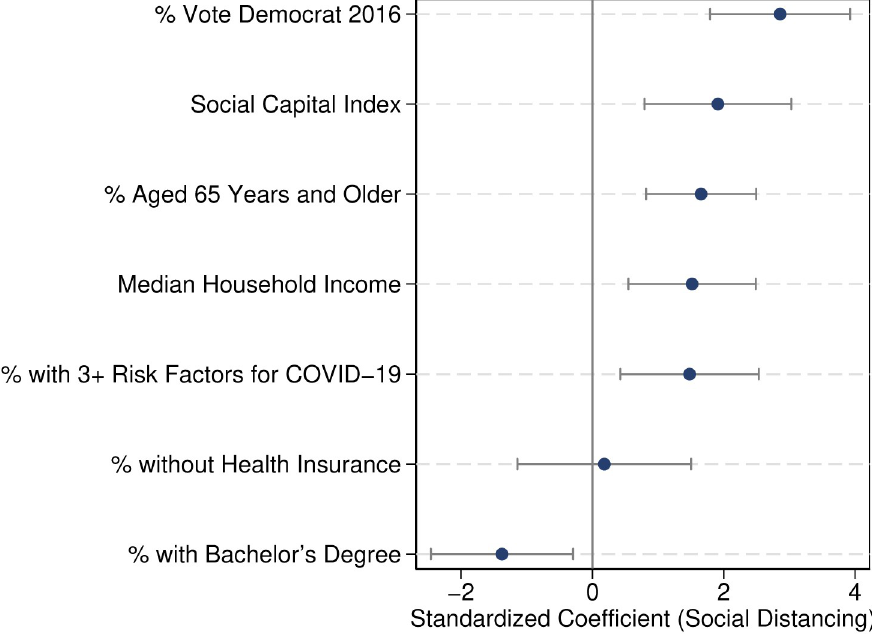
Fig 1. Determinants of social distancing. Notes : This figure plots estimates on determinants of social distancing from Table 3. See corresponding footnotes for details.